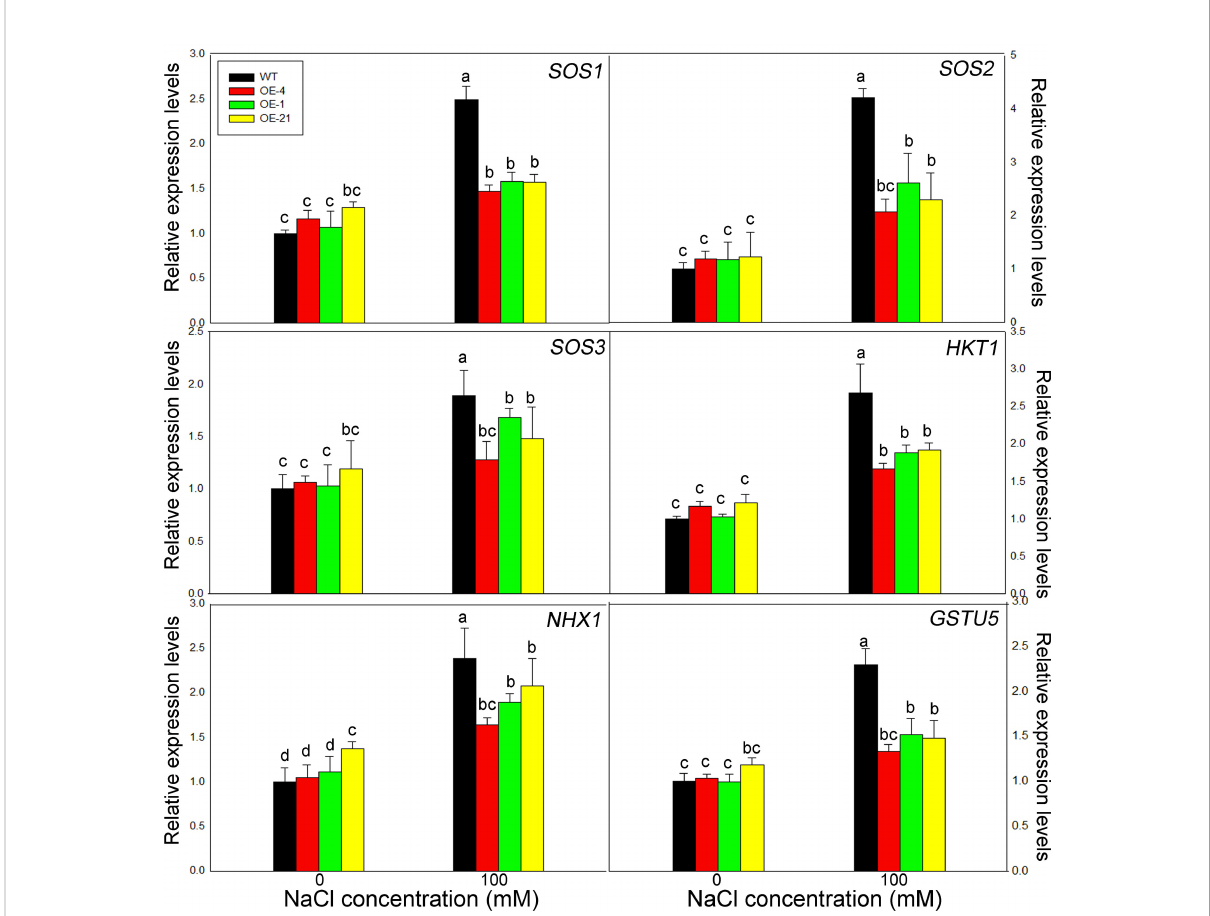
FIGURE 6 Expression levels of salt resistance – related marker genes in Lb1G04794 transgenic Arabidopsis lines. Relative expression levels of AtSOS1 , AtSOS2 , AtSOS3 , AtHKT1 , AtNHX1 , and AtGSTU5 . WT and 35S:Lb1G04794 (OE 4, OE 1, and OE 21) Arabidopsis lines were grown for 7 days on half-strength MS medium (0) or with 100 mM NaCl. Data are means ± SD of three seedlings; different lowercase letters indicate signi fi cant differences at P = 0.05 according to Duncan ’ s multiple range